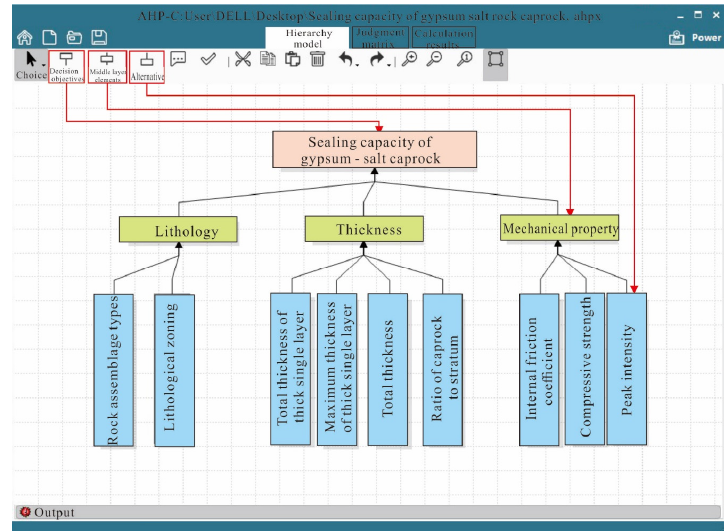
Figure 7. Hierarchy modeling in AHP software. The red line in the figure is the identification, and the corresponding icon is clicked to establish the hierarchical relationship.